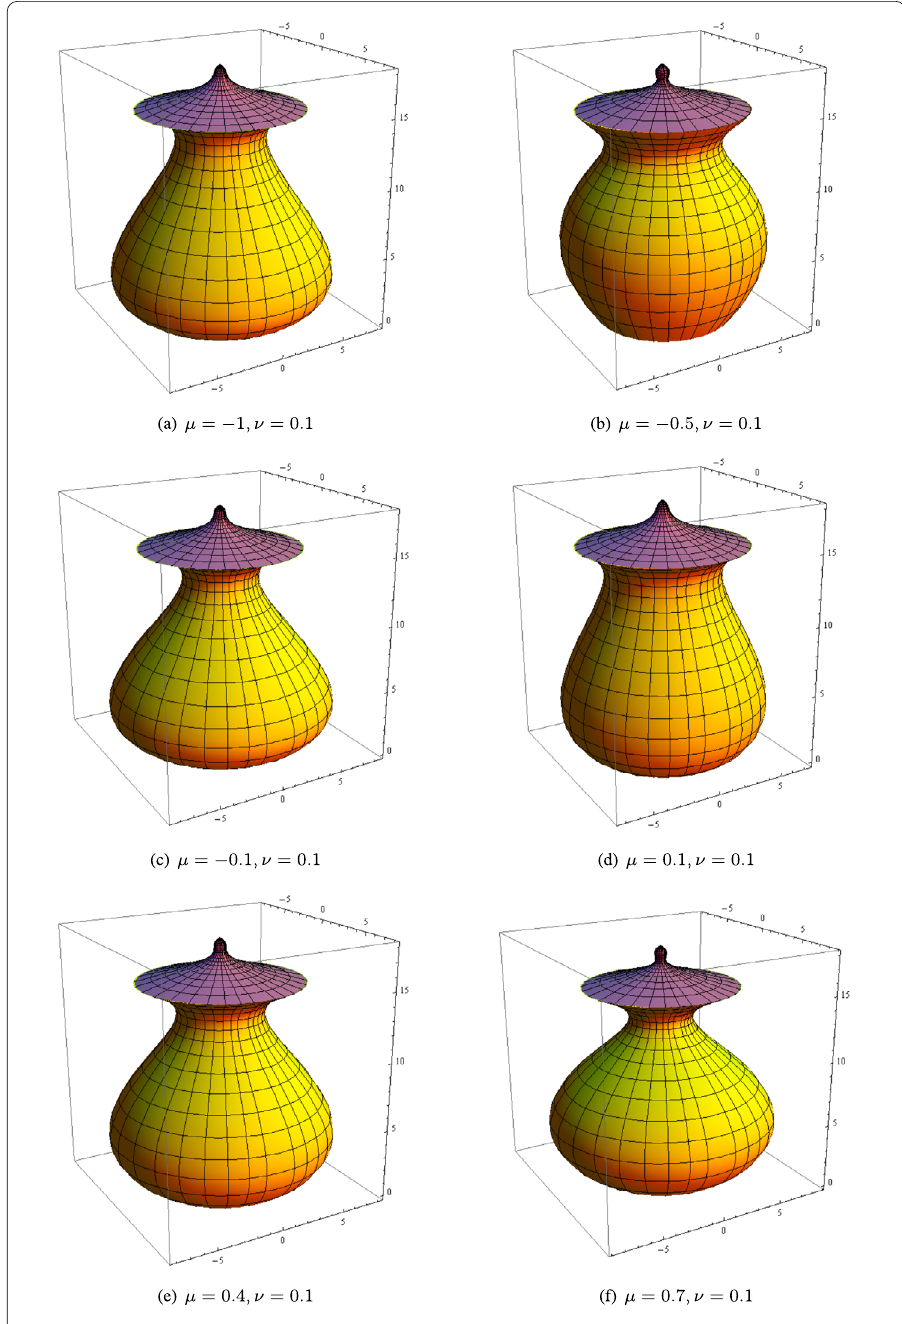
Figure 25 Designing of GBT-Bézier rotating ceramic pot